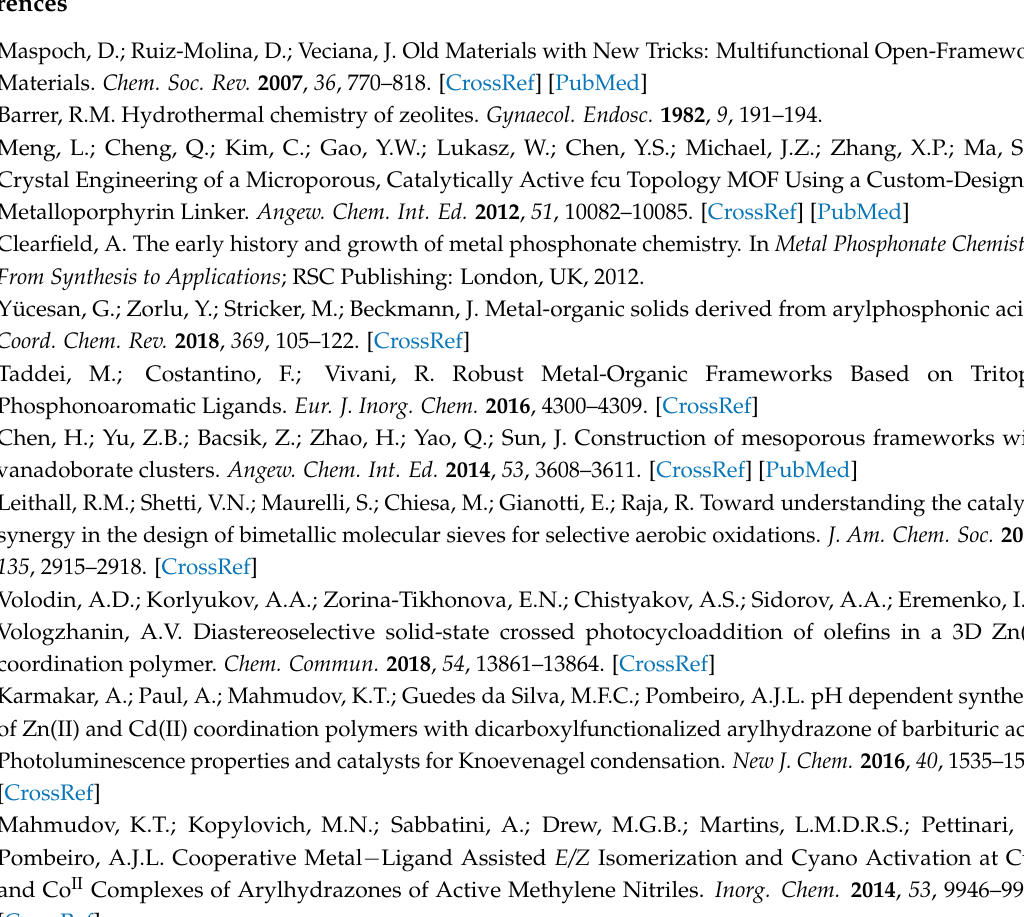
Supplementary Materials: The following are available online: Figure S1: TG curve of compound 1 in N 2 , Figure S2: The FT-IR spectrum of compound 1 , Figure S3: UV-Vis-NIR diffuse reflectance spectrum of compound 1 , Figure S4: XPS spectrum of vanadium in compound 1 . The peak at 516.2 eV is attributed to V 4+ and a shoulder at about 517.1 eV is assigned to for V 5+ , Figure S5: The chromatogram for the oxidation of α -phenethyl alcohol to acetophenone. (a) Products; (b) α -phenethyl alcohol standard sample; (c) acetophenone standard sample, Figure S6: The XRD patterns of compound 1 collected before and after the catalytic reactions, Table S1: Comparison of crystal structure of compound 1 obtained in this study with other reprehensive reports on three-dimensional open-framework borovanadates; Table S2: Bond lengths [Å] for compound 1 ; Table S3: Bond angles [deg] for compound 1